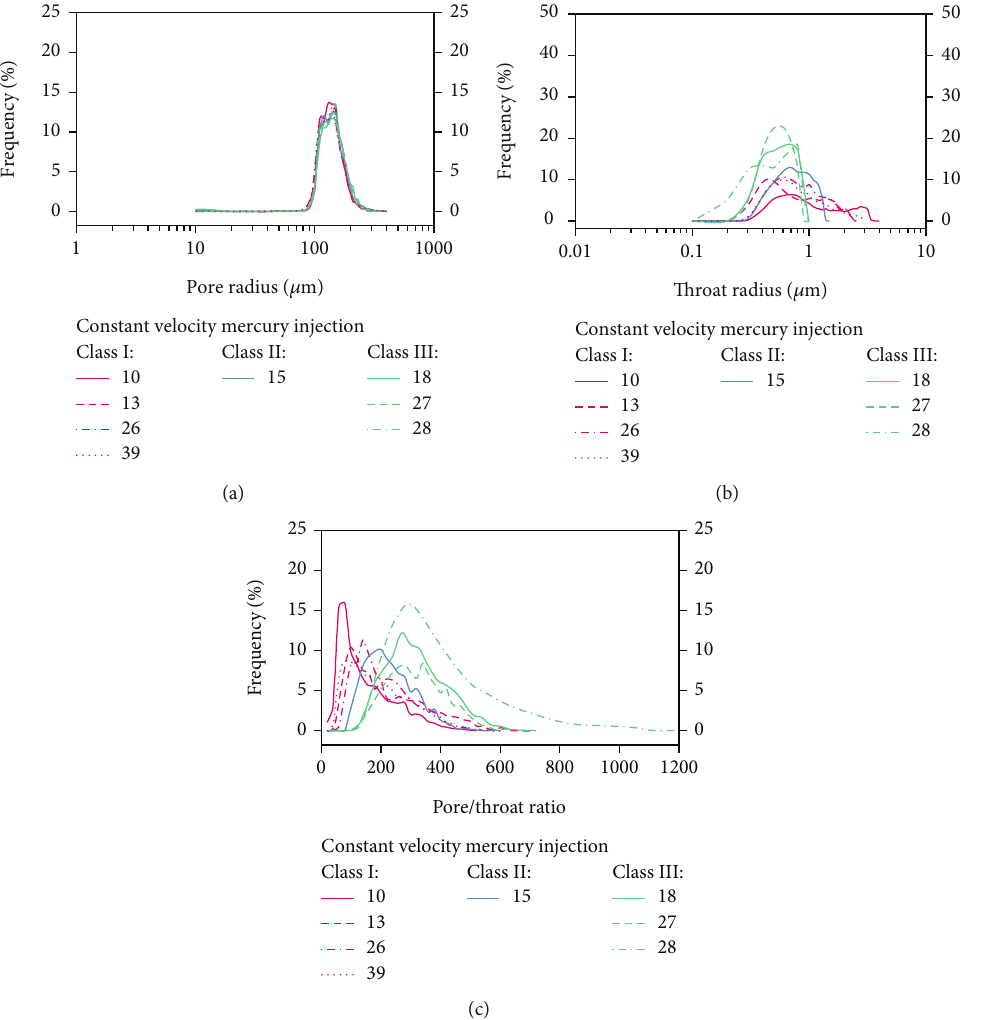
Figure 5: Distribution frequency curve of pore radius, throat radius, and pore throat ratio in constant velocity mercury penetration test of C 6